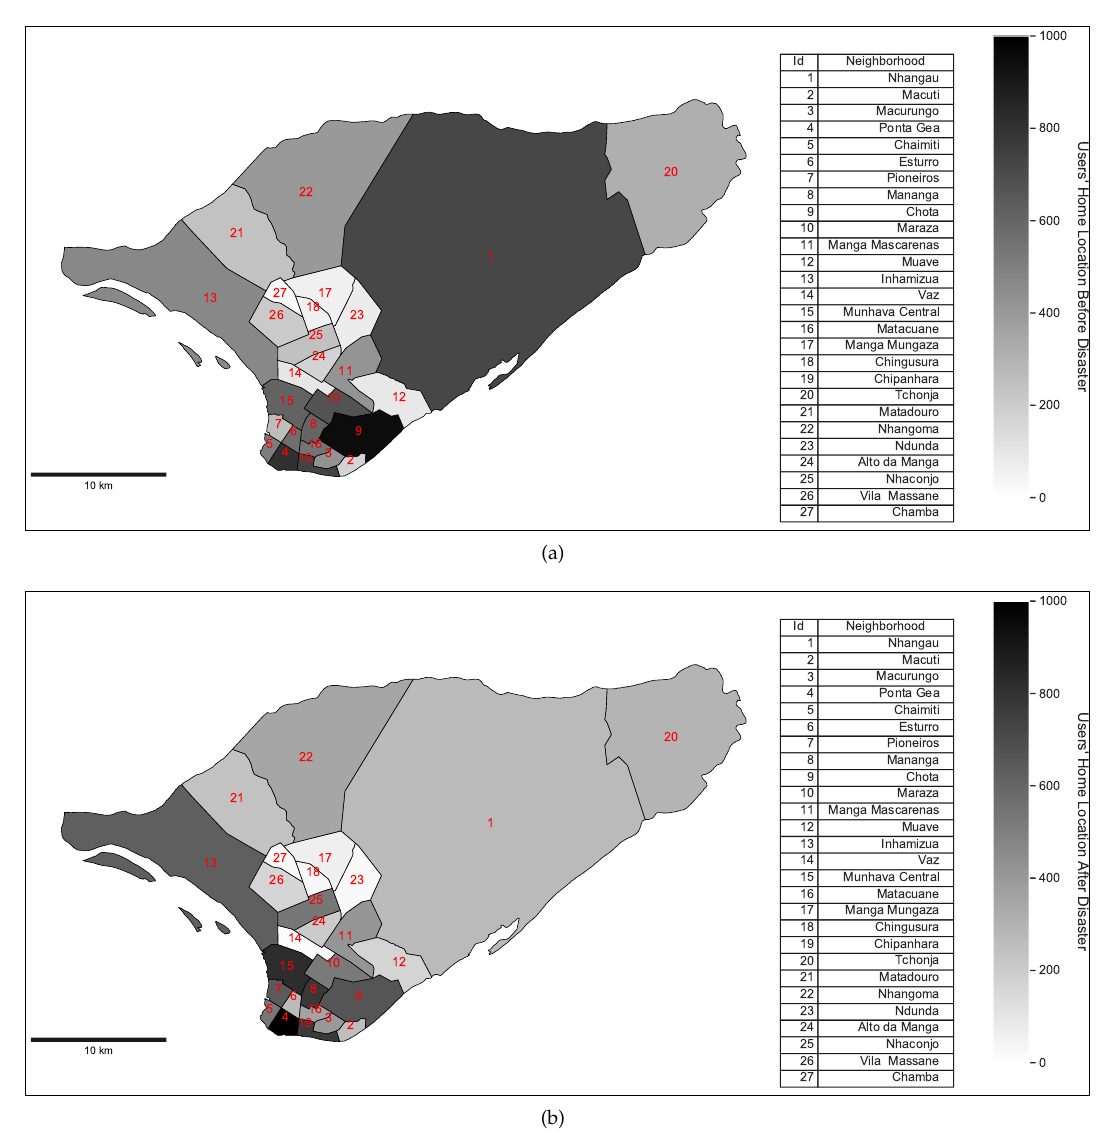
Figure 9. ( a ) Aggregated mobile phone users before the disaster at neighborhood level and ( b ) aggregated mobile phone users after the disaster at neighborhood